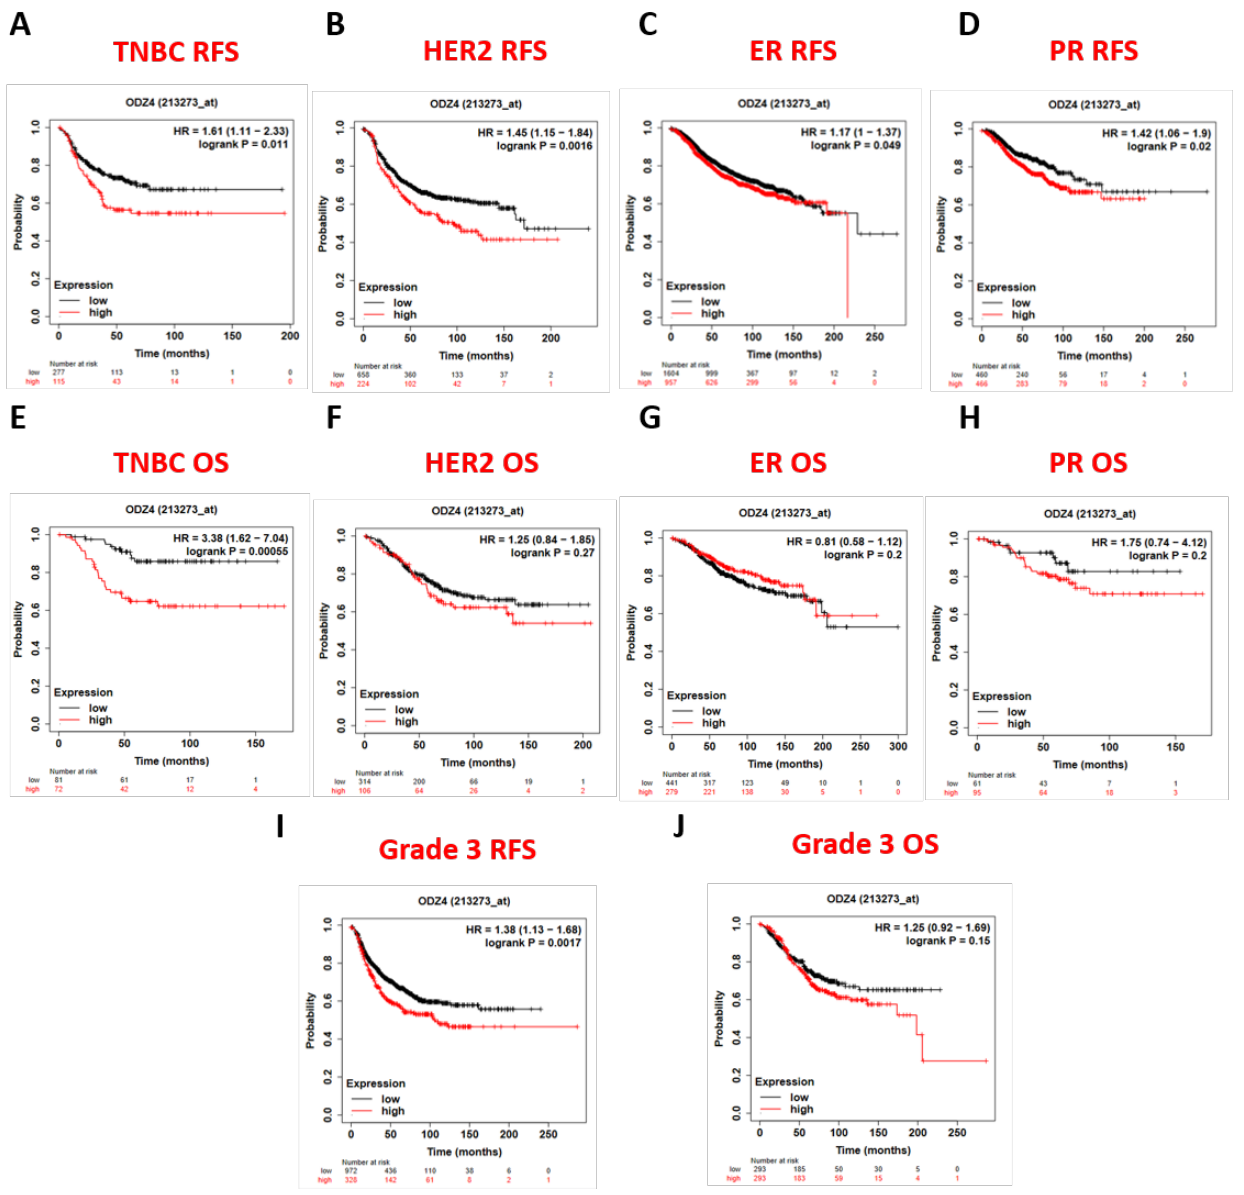
Figure 3. TENM4 mRNA expression relevance in breast cancer patients. Correlation between Relapse Free Survival (RFS) and Overall Survival (OS) in Triple Negative Breast Cancer (TNBC) ( A , E ), HER2-positive ( B , F ), Progesterone Receptor (PR)-positive ( C , G ), Estrogen Receptor (ER)-positive ( D , H ), and Grade 3 ( I , J ) with high (red) or low (black) TENM4 mRNA expression in the tumor.